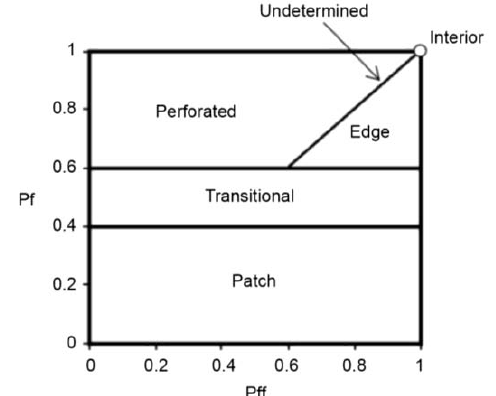
Fig. 3. The model used for identification of forest fragmentation components based on local measurements of P f and P ff within a given block (adapted from Riitters et al. 2000 – Erratum 2)